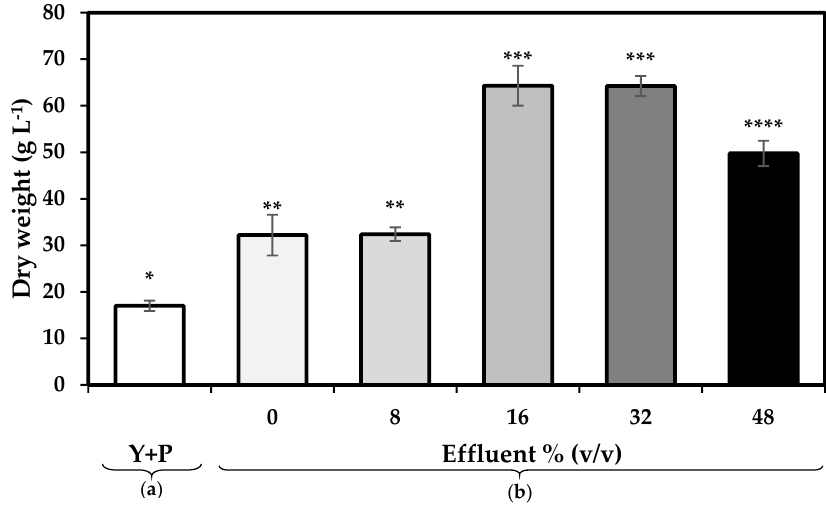
Figure 1. Comparison of biomass productivity of S. limacinum in growth media containing the same carbon (120 g L − 1 crude glycerol) concentration and ( a ) yeast and peptone (Y+P) and micronutrients or ( b ) varying volumes of effluent digestate (0–48%) combined with NH 4 Cl that resulted in the same nitrogen (3.3 g L − 1 ) concentrations, without additional micronutrients. Values are represented as mean ± standard deviation of triplicates, whereas asterisks indicate statistical differences analyzed at a level of p < 0.05.